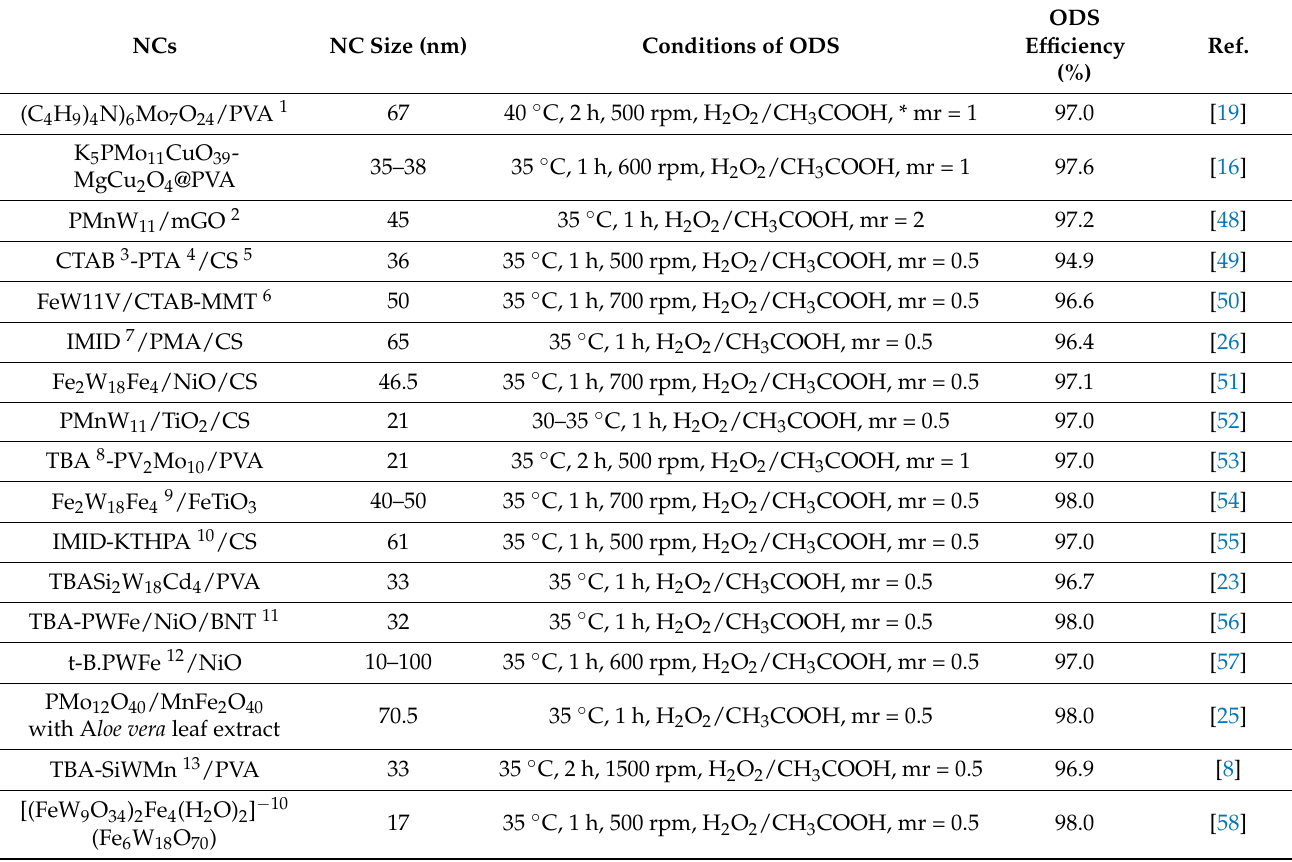
Table 1. Examples of NCs for ODS of gasoline with initial sulfur concentration 398–500